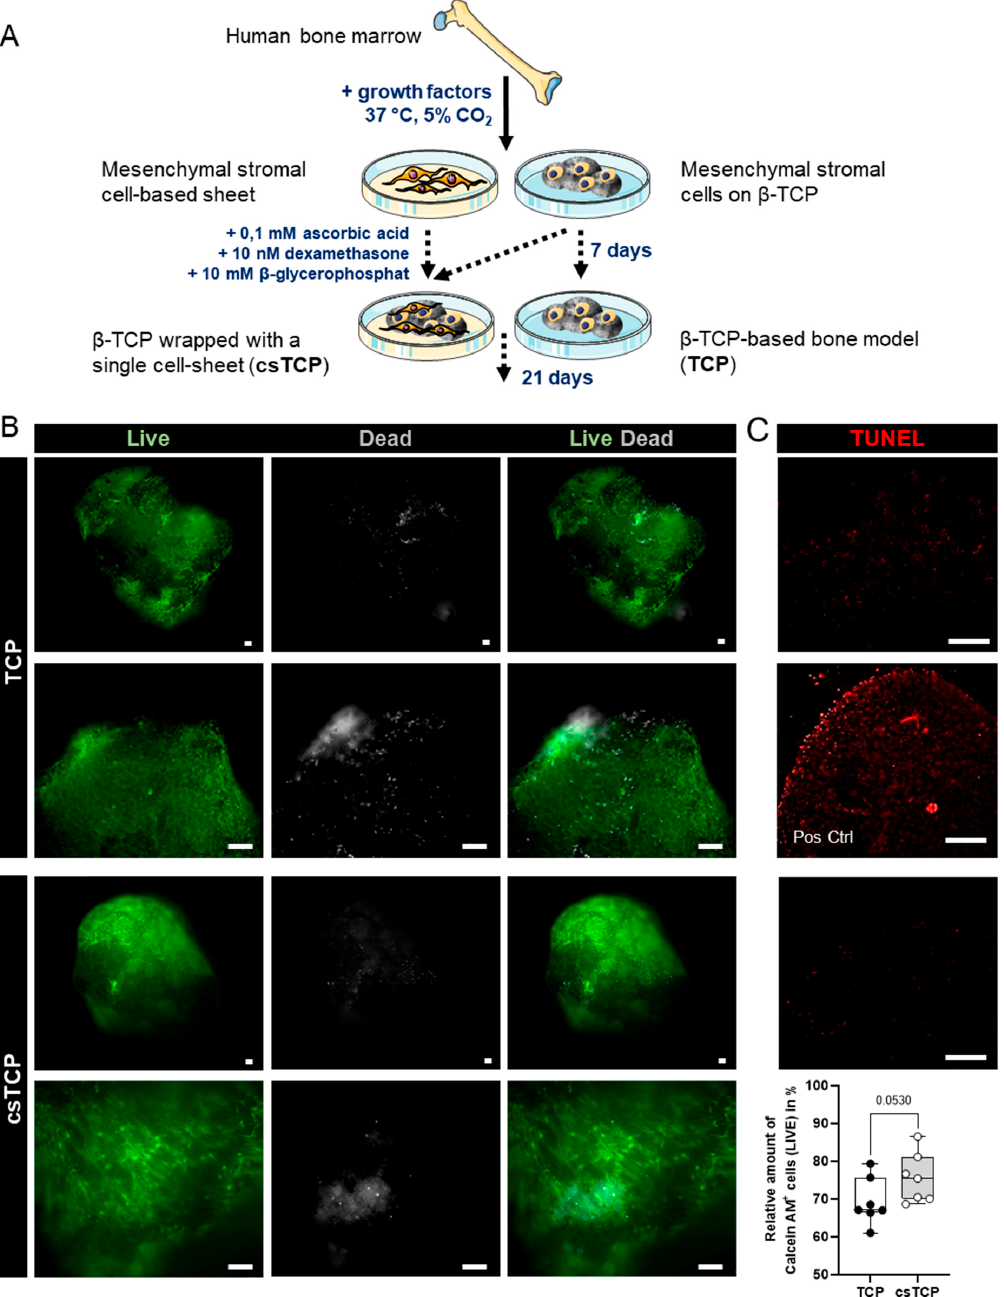
Figure 1. MSC-based cell-sheet wrapping enhanced the survival rate of MSCs seeded on TCP. ( A ) MSCs were seeded on (i) β -TCP particles (TCP) and (ii) temperature-responsive dishes. The latter was osteogenically differentiated for 7 days, then wrapped around TCP (csTCP), and differentiated for 21 days. ( B ) Representative images of LIVE/DEAD staining were conducted at 21 days and quan- tified using ImageJ. Living cells are presented in green (Calcein-AM+) and dead cells in grey (EthD+). ( C ) Detection of apoptotic cells (red) using TUNEL staining at day 21 with and without cell-sheet technology. Pos Ctrl = DNase I treatment for 10 min. Data are shown as box plots (center- line, median; box limits, upper and lower quartiles; whiskers, maximum and minimum values; all data points); n = 7. Scale bars show 100 µm. Statistics: Two-tailed Mann–Whitney U test.